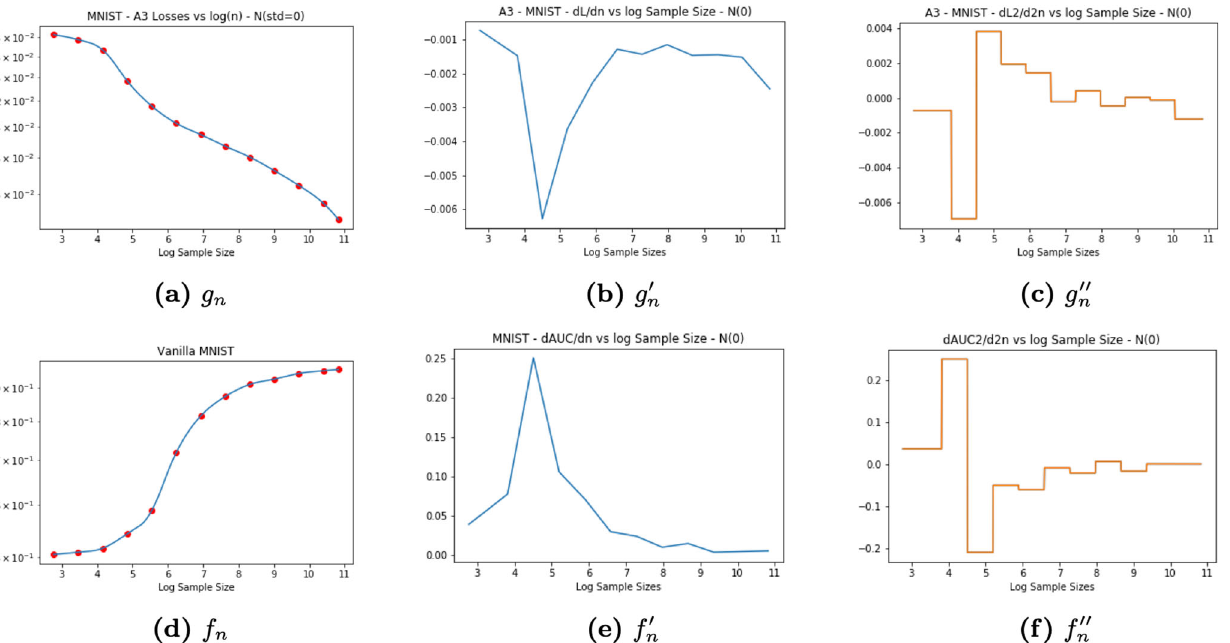
Fig. 2 Comparison of autoencoder learning curve with generalizability of a fully connected network. f is a fully connected network with input dimension of 784 and output dimension 10, and g an autoencoder with an input dimension of 784 and a latent space of dimension 3. a The loss of the autoencoder displays a curve split into two phases: the quick phase and the slow phase. b The fi rst derivative of the autoencoder loss function displays a decay phase and a growth phase. c The second derivative reveals a sharp in fl ection point where the slope changes from sharply decreasing to sharply increasing. d The area-under-the-curve metric on the test set displays a biphasic structure: a rapid growth phase and a slow growth phase. e The fi rst derivative of the AUC curve reveals a rapidly increasing phase followed by a decreasing phase. f The second derivative of the AUC curve reveals an in fl ection point as a mirror image of the autoencoder loss β is a scaling constant. We tested this hypothesis by calculating the correlation coef fi cient below the MCSE and above the MCSE, and results are reported in Table 1. A signi fi cant R 2 indicates a linear correlation between loss and power. We used eight